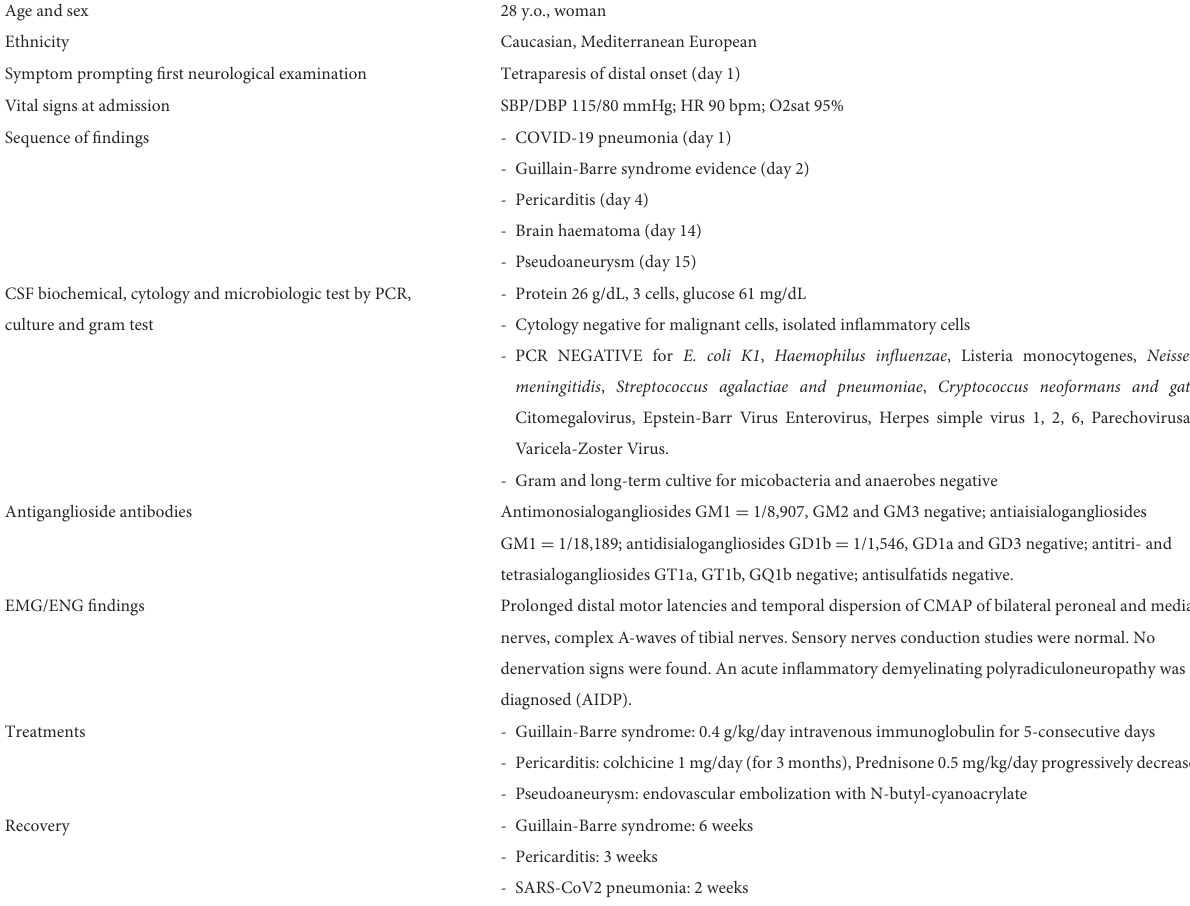
TABLE 1 Patient’s demographic and clinical